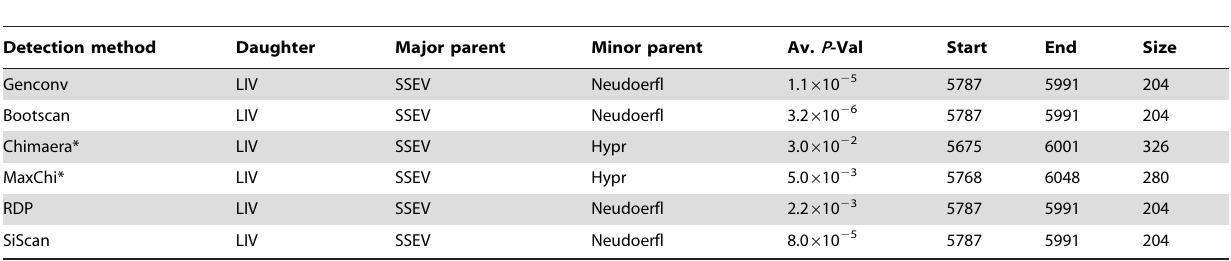
Table 1. Localization of the recombination breakpoints with different methods in RDP3 on an alignment of 28 full-length coding genomes, analyzed with Bonferroni correction and P -value ,